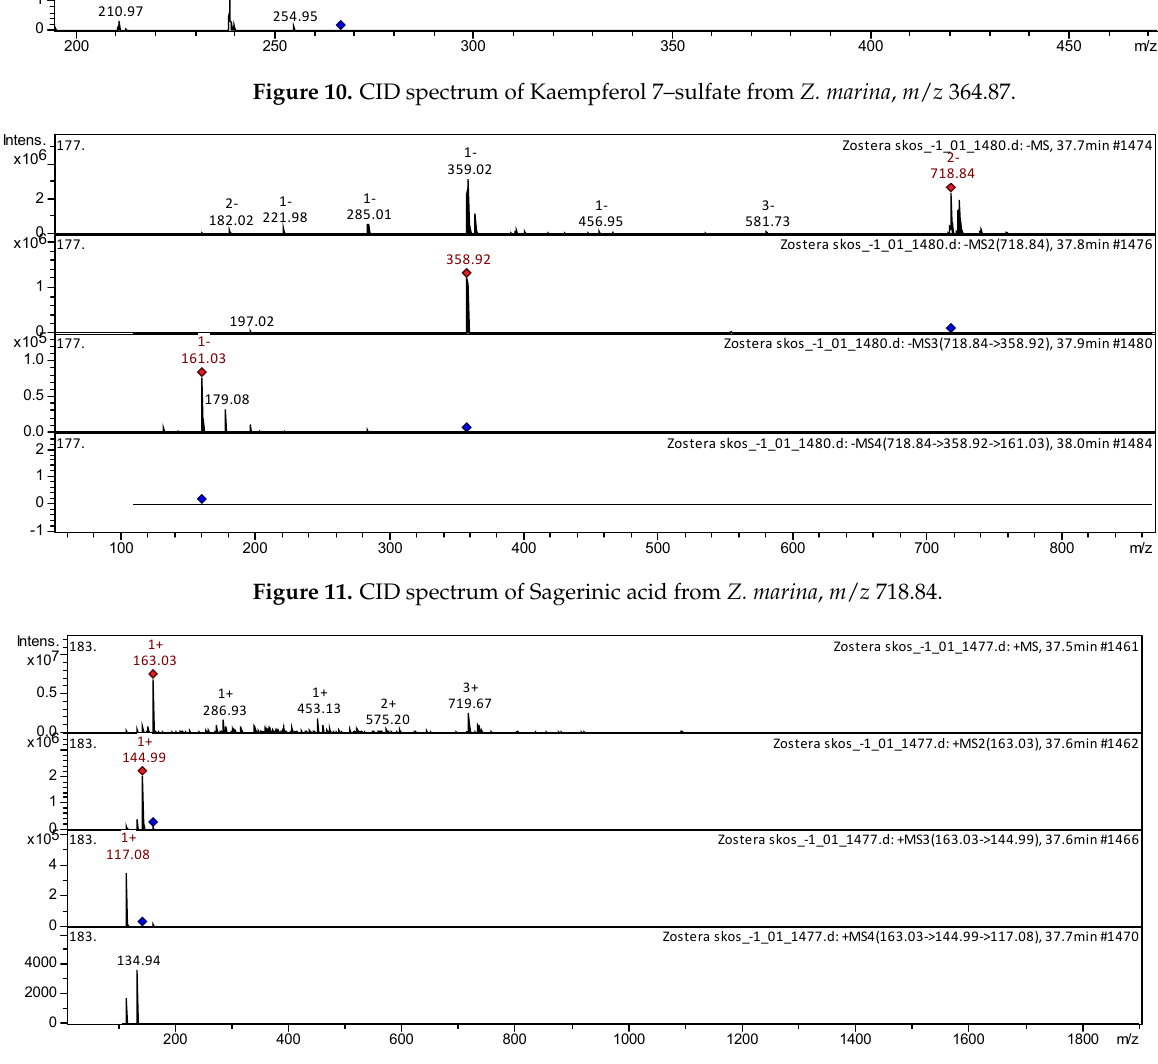
Figure 12. CID spectrum of Umbelliferone from Z. marina , m/z 163.03.